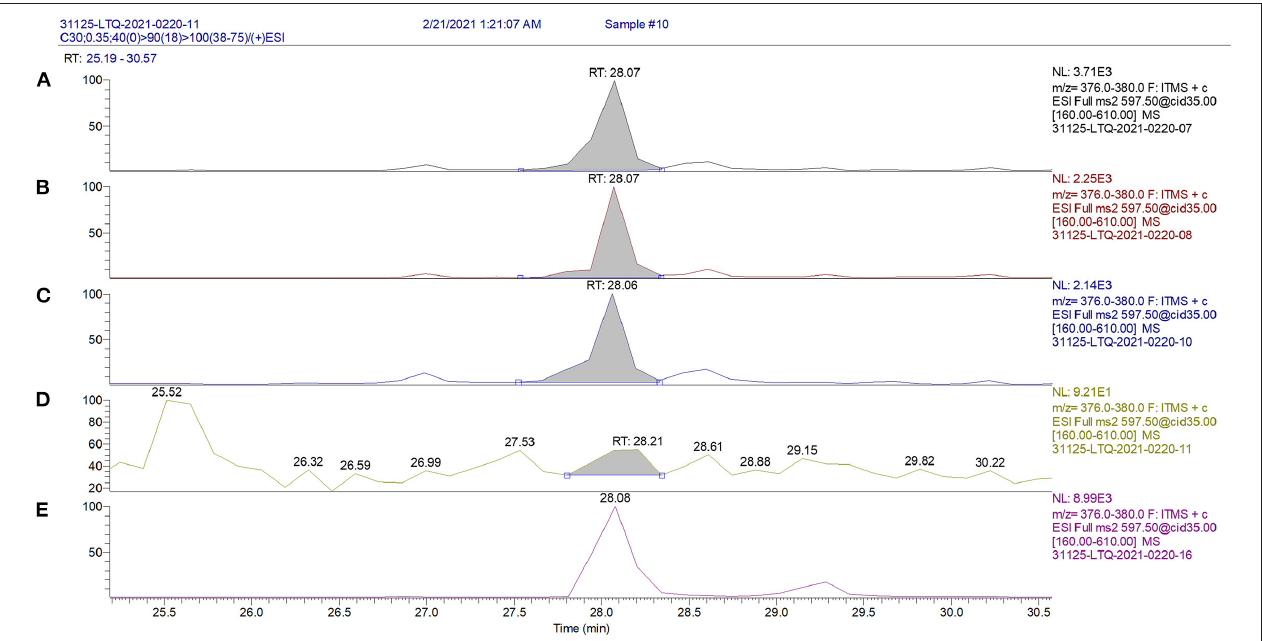
FIGURE 3 | Identification of astaxanthin in T1 N. benthamiana plants through the mass peaks of product ions generated by HPLC/ESI( + )-MS/MS. The graph shows the 379.2 m/z mass peak from a plant expressing crtW (A) , Cit/crtW (B) , HBFD1 and CBFD2 (C) , empty vector (D) and an astaxanthin analytical standard (E) . HPLC/ESI( + )-MS/MS = high performance liquid chromatography, coupled with tandem mass spectrometry with positive electrospray